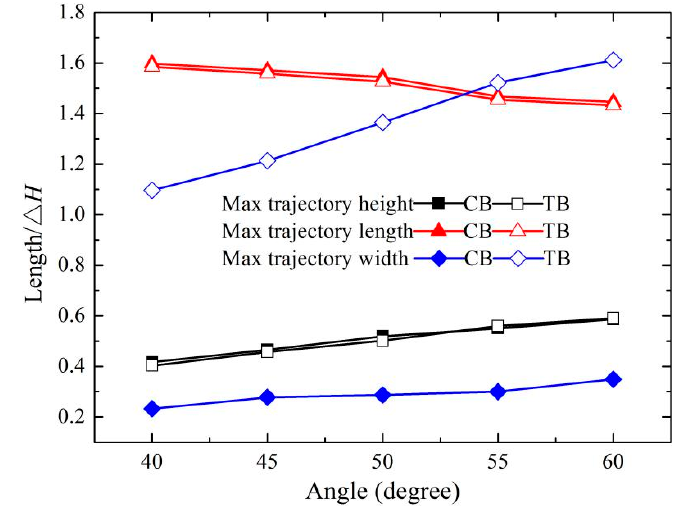
Figure 5. Hydraulic characteristics of the CB and TB at different bucket angles.